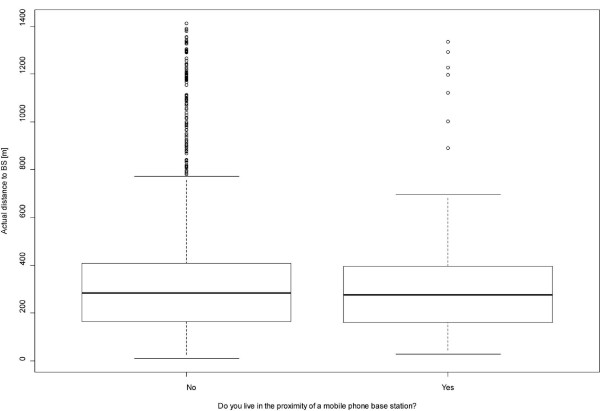
Box plot indicating the non-significant correlation between actual distance and perceived proximity to mobile phone base stations.